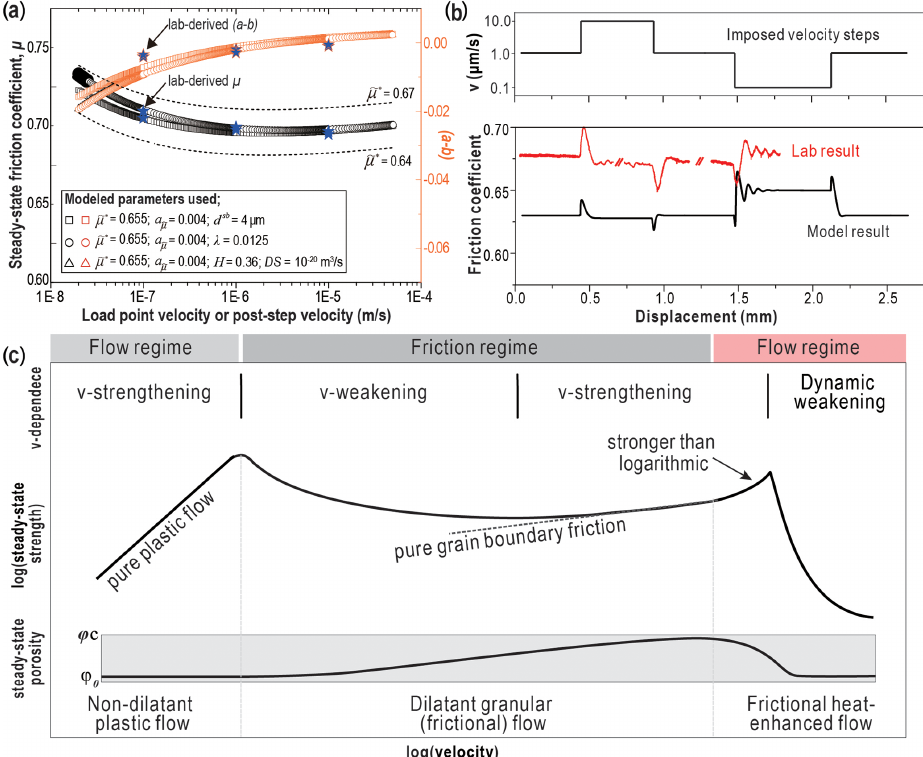
Figure 7. Reproduction of experimental data using the CNS model. (a) Steady-state frictional strength and ( a − b ) values, as well as (b) v -stepping tests. Data from experiments on calcite gouge performed at T = 80 ◦ C and σ eff n = 50MPa (see Fig. 5a). (c) Model output for a wide range of fault sliding rates.